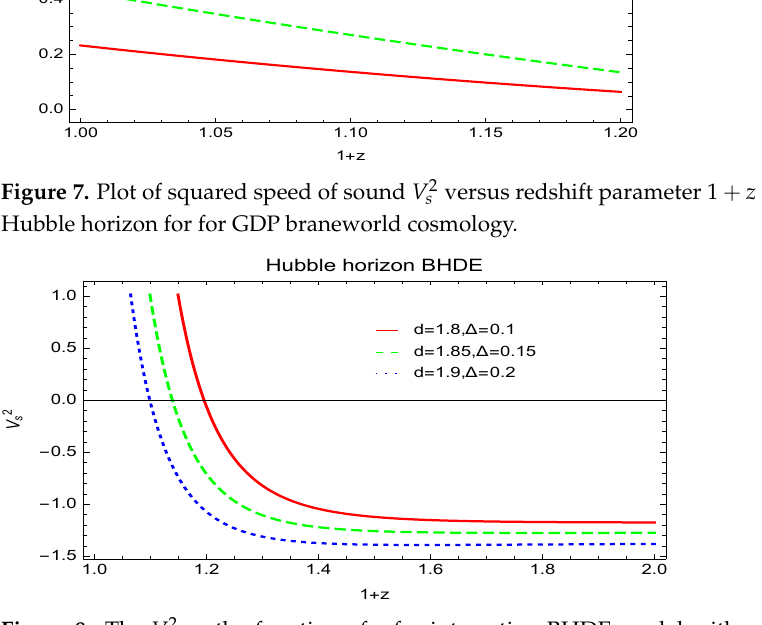
Figure 8. The V 2 s as the function of z for interaction BHDE model with event horizon for GDP braneworld